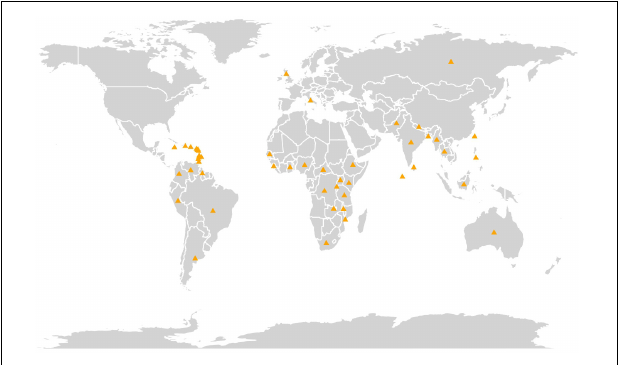
FIGURE 1 | A map depicting the country of collection of the 600 pigeonpea accessions and four checks conserved at Genebank, ICRISAT, India.